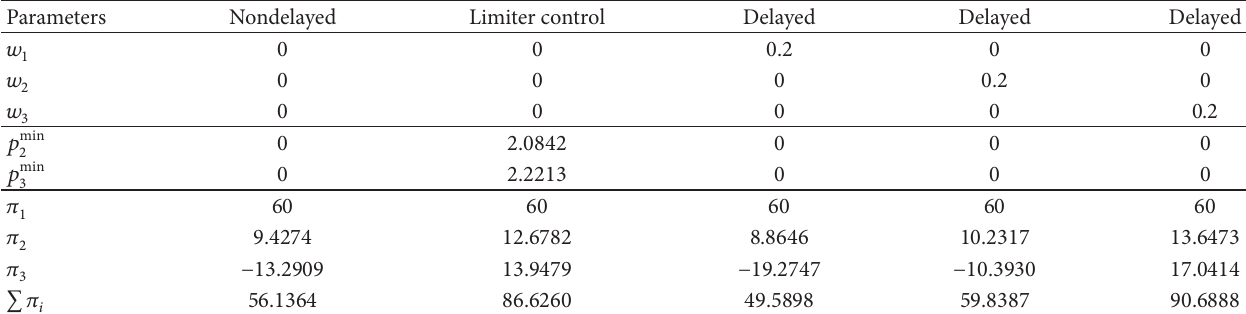
Table 3: Comparative analysis of oligarchs’ profits when 𝛼 = 0.5 , 𝛽 = 0.15 , and 𝛾 = 0.41